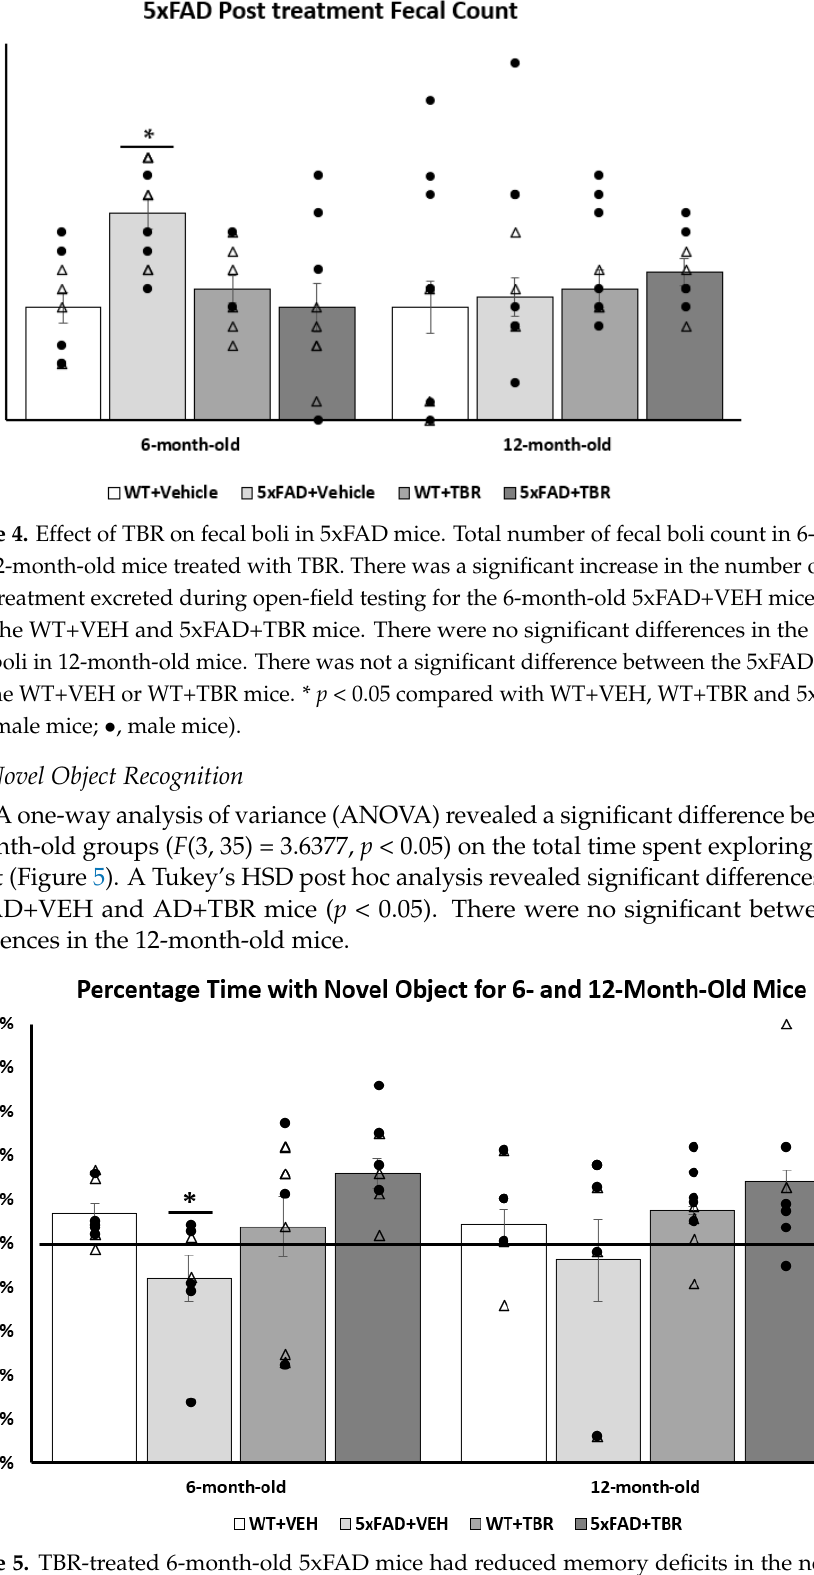
recognition task. The 6-month-old 5xFAD vehicle-treated mice spent a significantly shorter percentage